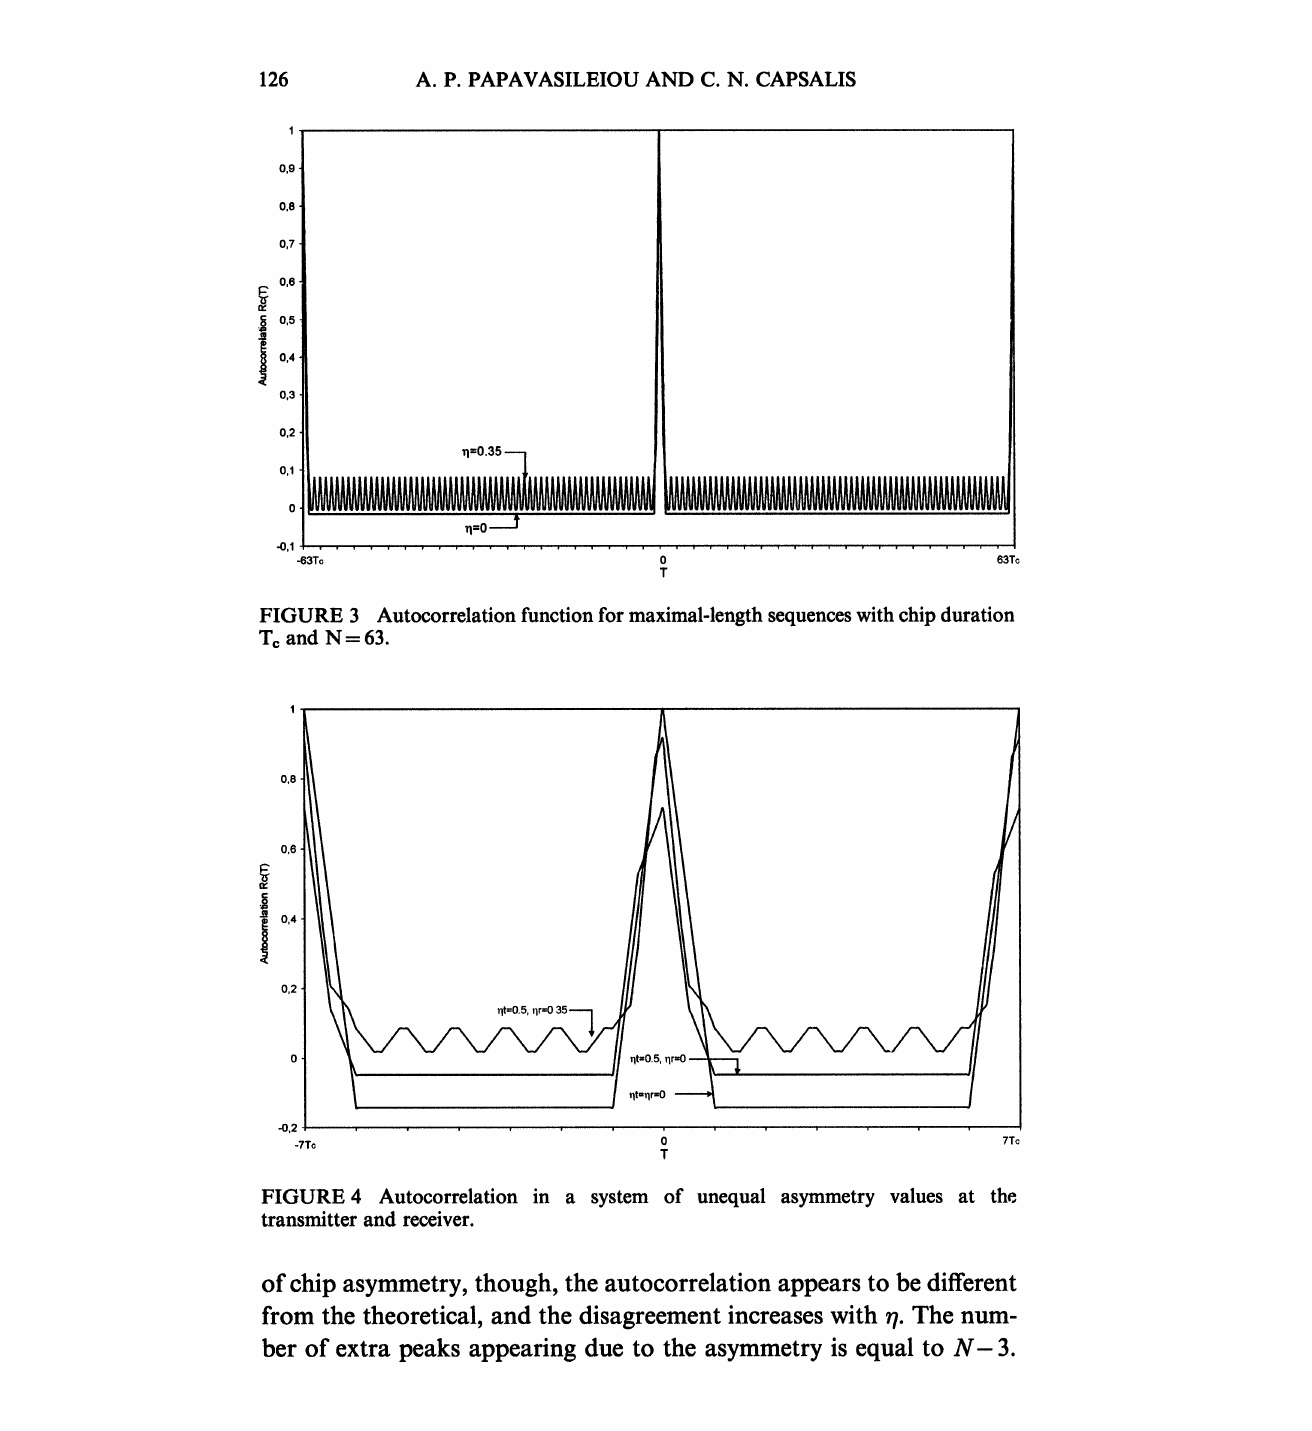
FIGURE 4 Autocorrelation in a system of unequal asymmetry values at the, transmitter and receiver. of chip asymmetry, though, the autocorrelation appears to be different from the theoretical, and the disagreement increases with r/. The num- ber of extra peaks appearing due to the asymmetry is equal to